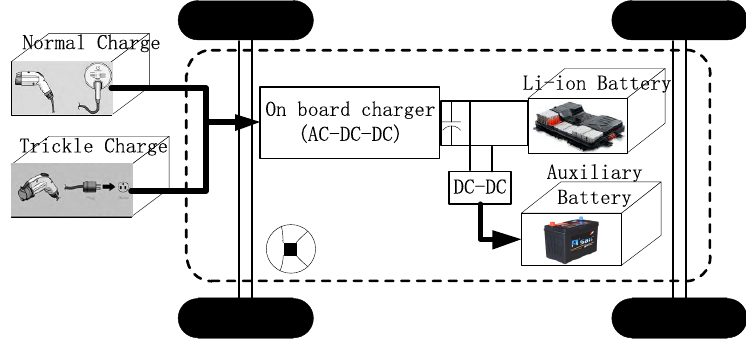
Figure 3. Structure of electric vehicle (EV) charging system.